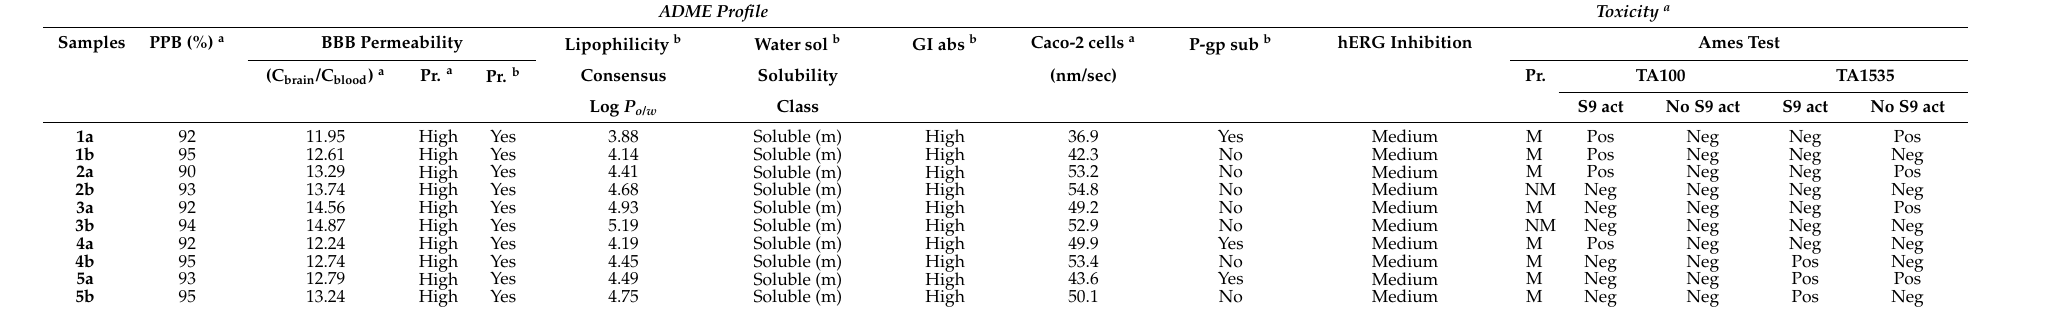
Table 3. Absorption, distribution, metabolism, excretion(ADME)and toxicity prediction of compounds ( 1a - 5a , 1b - 5b